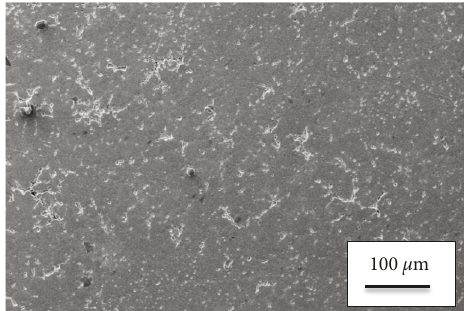
Figure 6: Tensile test result.